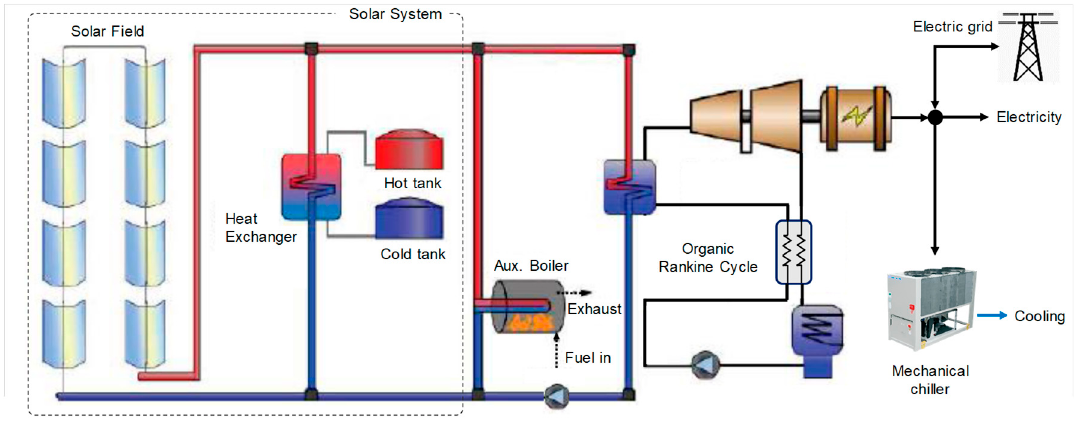
Figure 5. Simplified diagram of the analyzed parabolic trough–ORC–biomass cogeneration system. Adapted from Wagner and Gilman [52].